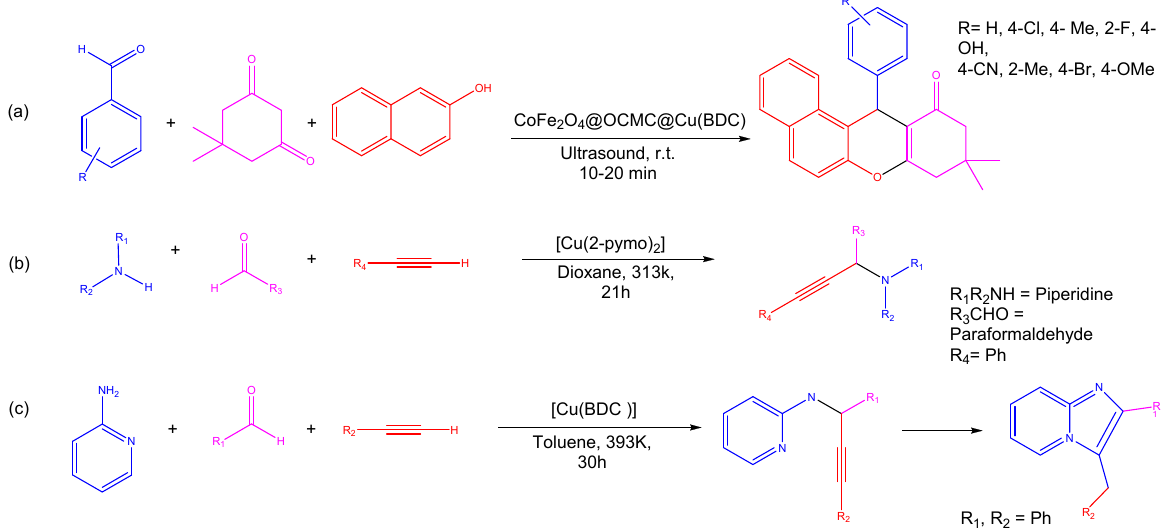
Figure 4. Different reactions catalyzed by Cu-MOFs ( a ) formation tetrazole from HKUST-1 MOF3 ( b ) three component coupling and cyclization reaction using Cu-MOF ( c ) single step three component coupling and cyclization reaction using CoFe 2 O 4 @OCMC@Cu(BDC) [82].